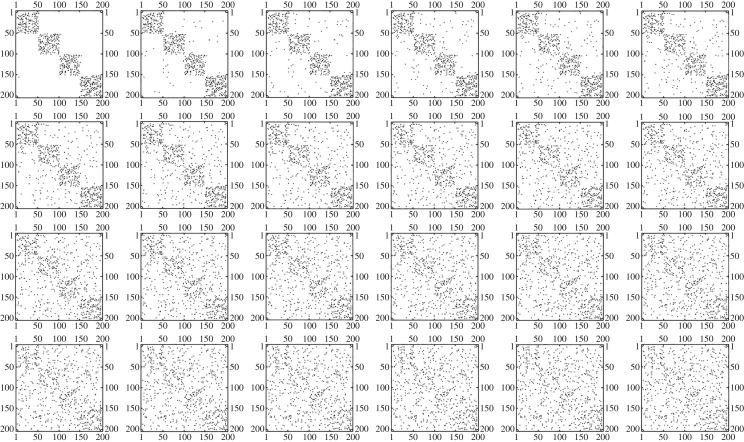
A random walk through Hn with n=200 vertices, starting from a graph with K=4 separate irreducible clusters, each with R=50 vertices and z=3, and joined together by a single directed edge cycle. We show the adjacency matrices for the graph after 20 successive edge swaps (applications of F), demonstrating that the method ensures average in/out degree of z=3 while homogenizing spread of edges.